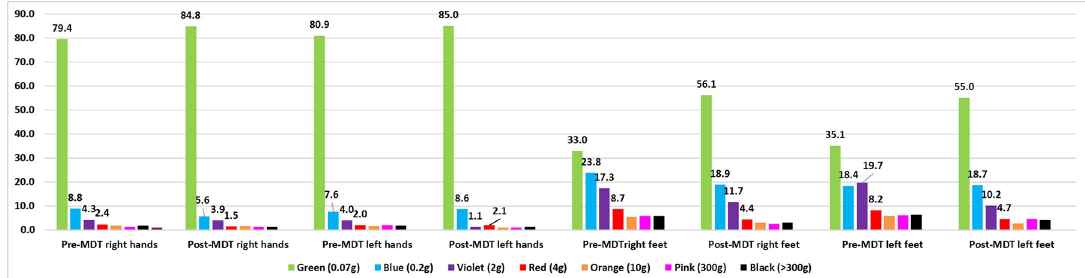
PLOS ONE | https://doi.org/10.1371/journal.pone.0272151 August 10,